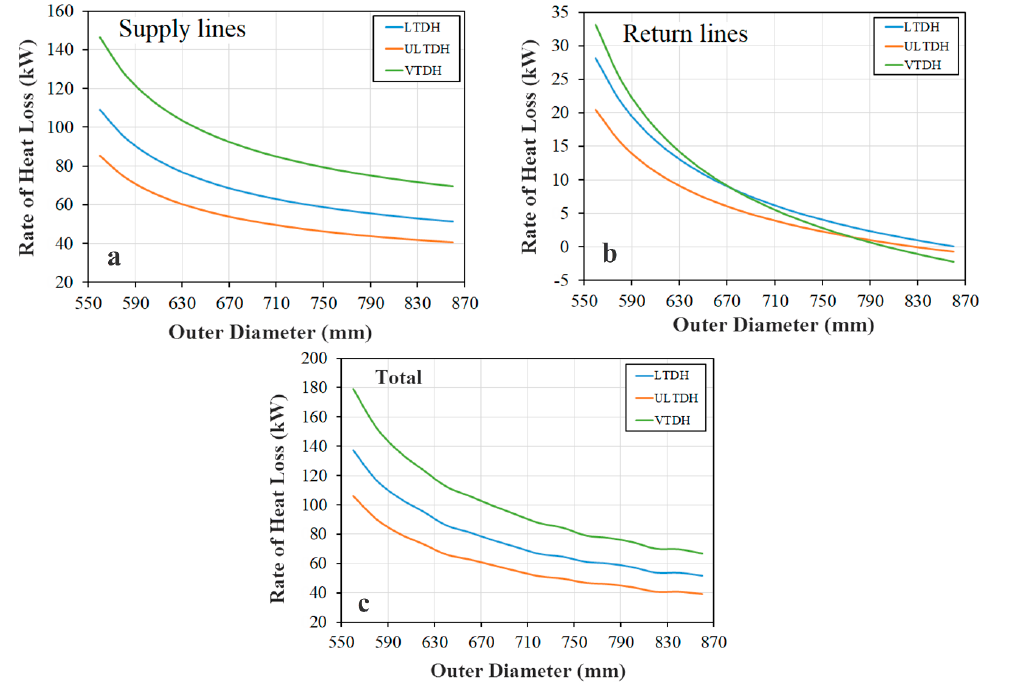
Figure 14. The effect of strengthening the insulation of pipes for various cases. ( a ) supply lines; ( b ) return lines; ( c ) total.